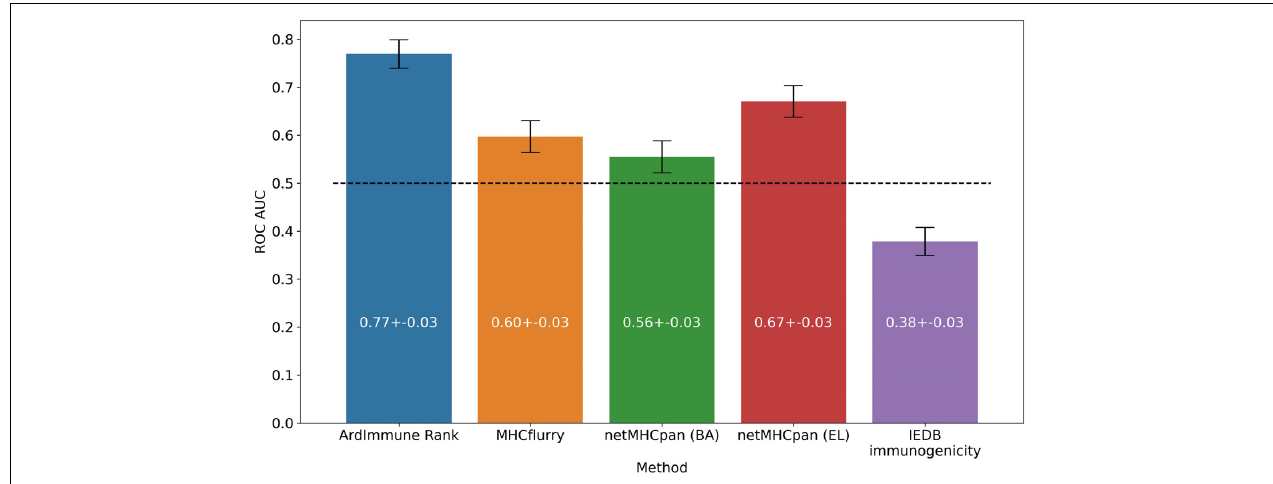
FIGURE 3 | Predictive performance of the selected models on the Coronaviridae dataset. ArdImmune Rank, blue bars; MHCflurry, orange bars. netMHCpan, green and red bars for the predicted binding affinity (BA) and ligand likelihood (EL); IEDB immunogenicity, purple